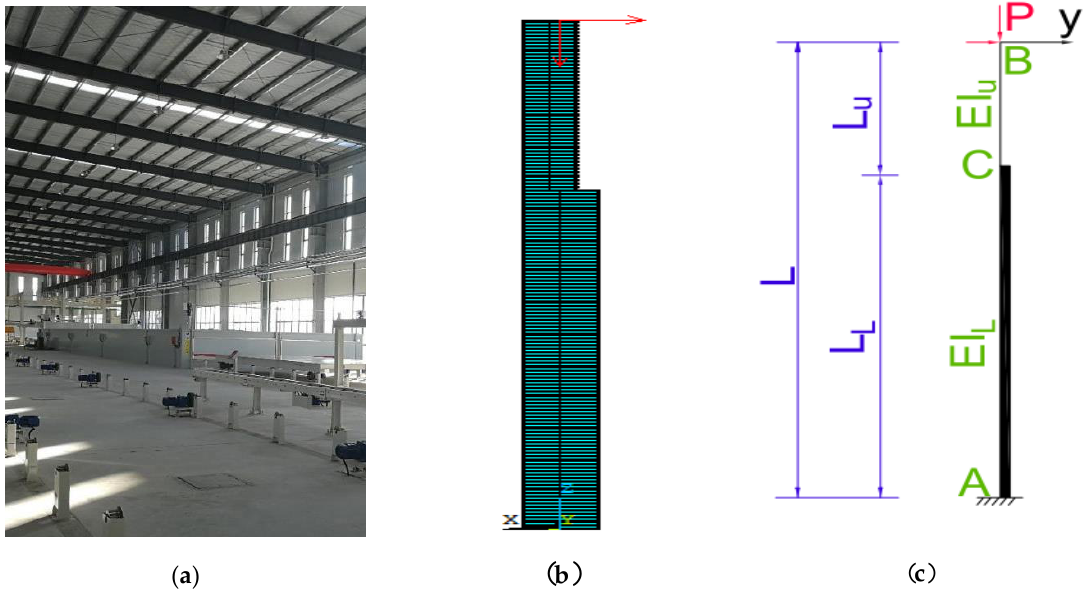
Figure 1. The actual drawing of the steel bent frame column, the detailed drawing of the bent column model, and the schematic diagram: ( a ) Actual drawing; ( b ) detailed drawing; ( c ) simplified drawing.